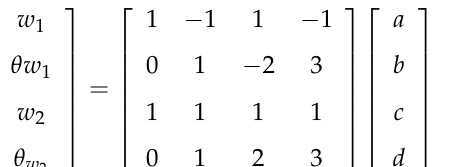
Figure 2. DOF for the hexahedron.